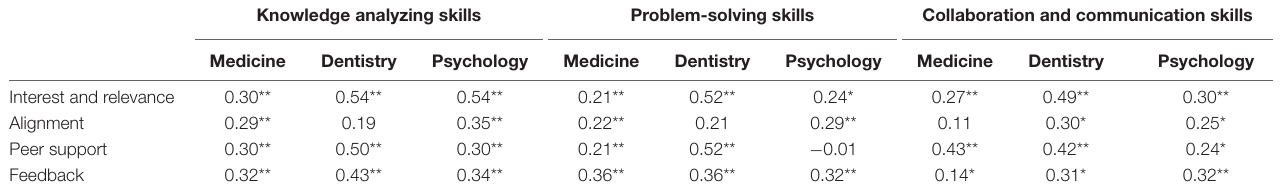
TABLE 4 | Correlations between perceived generic skills and perceptions of the teaching and learning environment among Finnish students in medicine ( n = 215), dentistry ( n = 70) and psychology ( n =